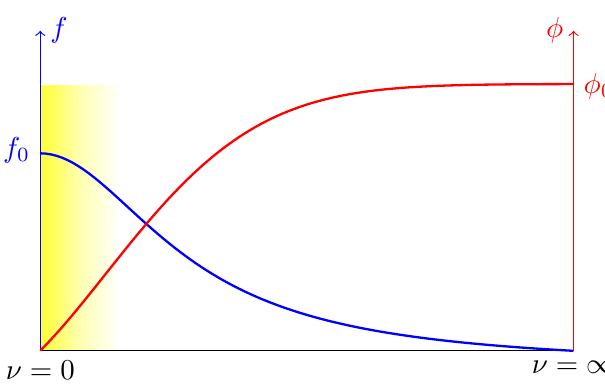
Figure 3 . The expected behavior of (cid:30) and f as a function of radial distance (cid:23) for a topological defect. The region with the gradient shade in yellow represents the core of the